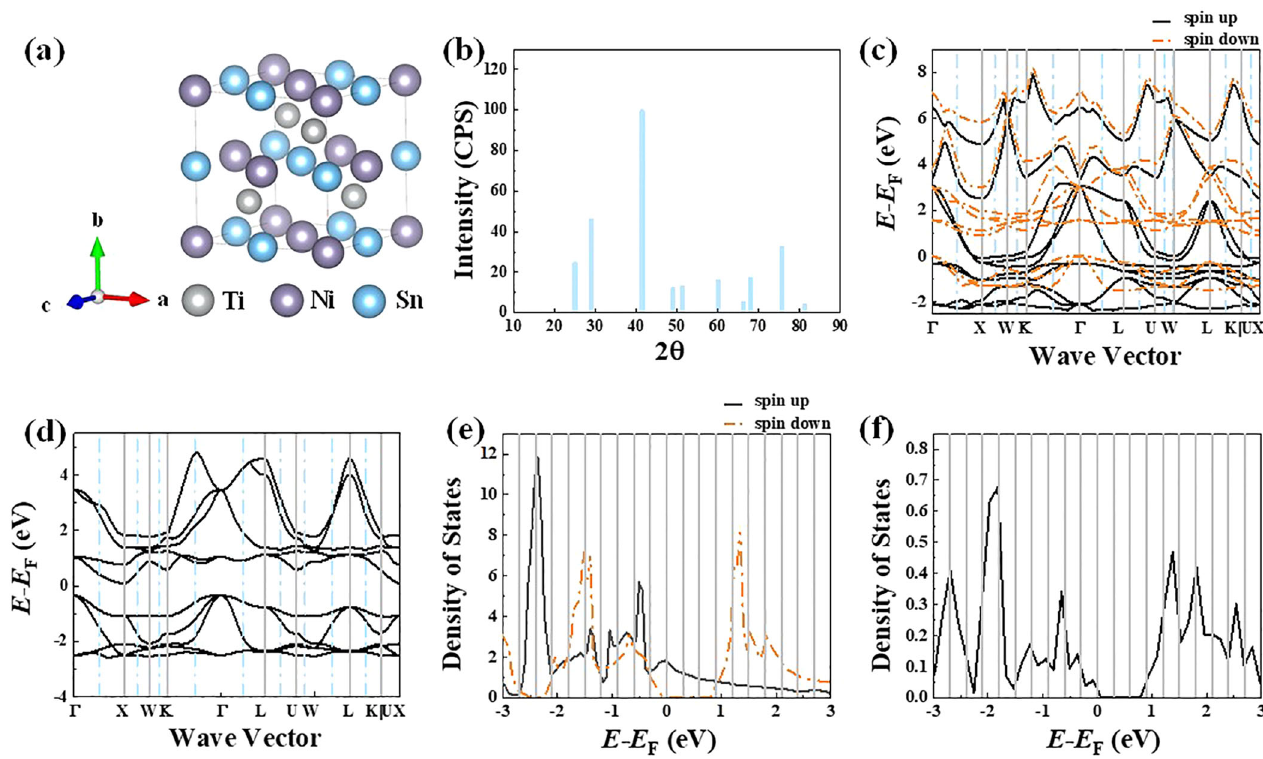
Fig. 1 Characteristics describing TE performance that provided by the Materials Project. a Crystal structure and b calculated X-Ray diffraction patterns of TiNiSn (materials_id: mp-924130 in the Materials Project)). c , d Band structure and e , f density of states for two spin states material (e.g., MnCoSb (materials_id: mp-5381)) and one spin state material (e.g., TiNiSn (materials_id: mp-22377 in the Materials Project)),